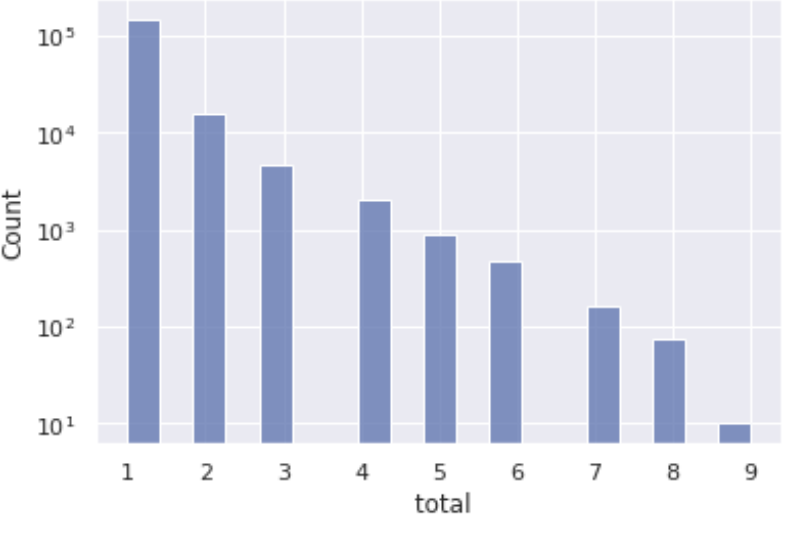
Figure 5. Quantitative data regarding number of rules by weights.